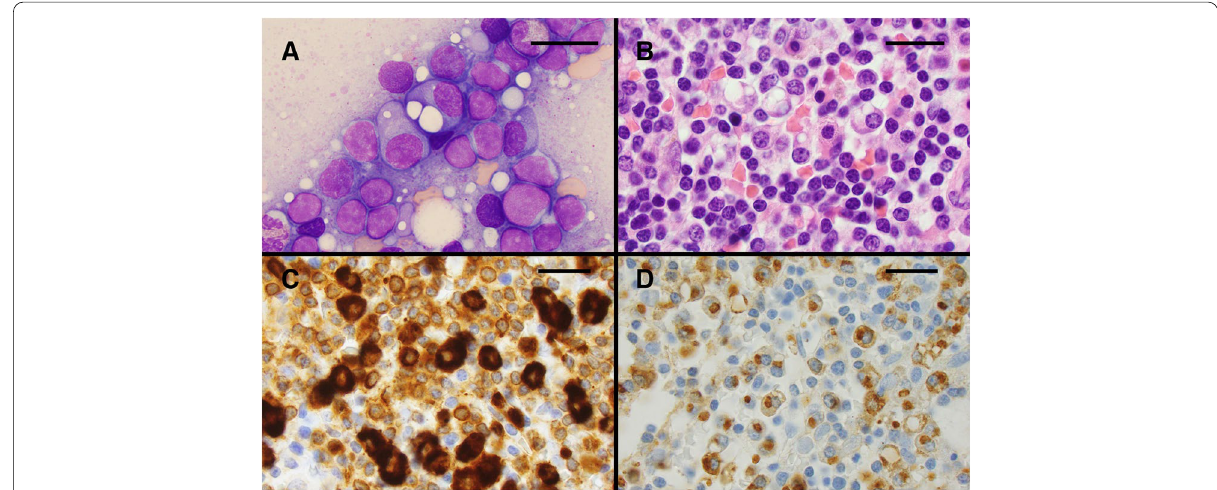
Fig. 1 Morphologic features of mu heavy chain disease. The bone marrow was markedly hypercellular due to a diffuse proliferation of small lymphocytes and plasma cells with prominent cytoplasmic vacuolization ( A : bone marrow aspirate, Wright-Giemsa stain, 1000 and B : × bone marrow core biopsy, hematoxylin and eosin stain, 1000 ). The immunohistochemical studies performed on the bone marrow biopsy × demonstrated that the B-cells and plasma cells were strongly positive for IgM ( C : 1000 ) and the plasmacytic component strongly expressed × kappa light chains ( D : 1000 ). Scale bars indicate 20 ×